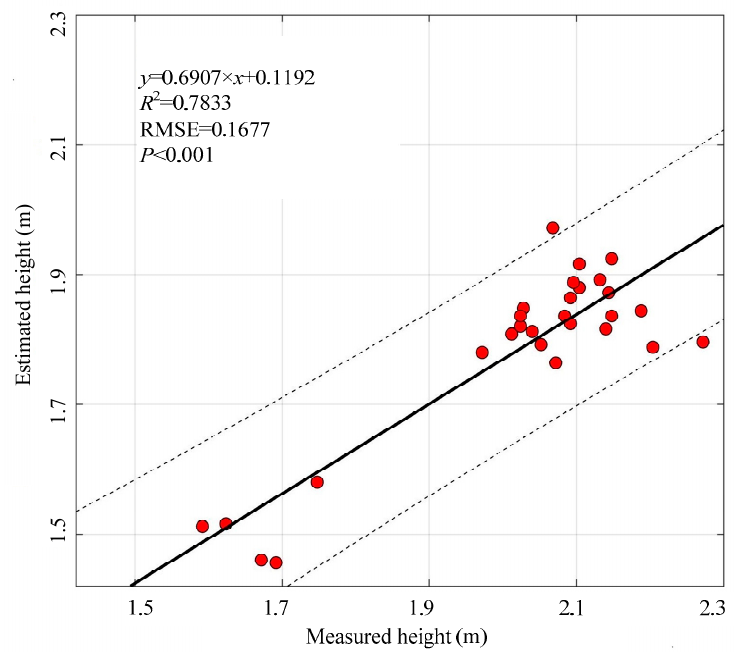
Figure 5. Comparison between the heights measured in situ and the estimated heights. The broken lines represent the 95% confidence interval.